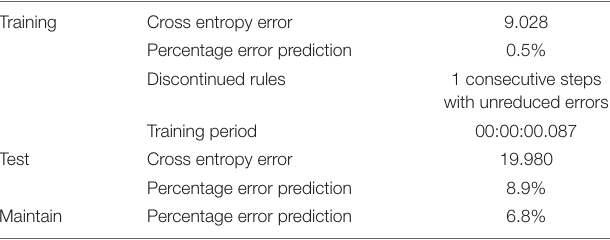
TABLE 2 | Summary table of BP artificial neural network evaluation model.